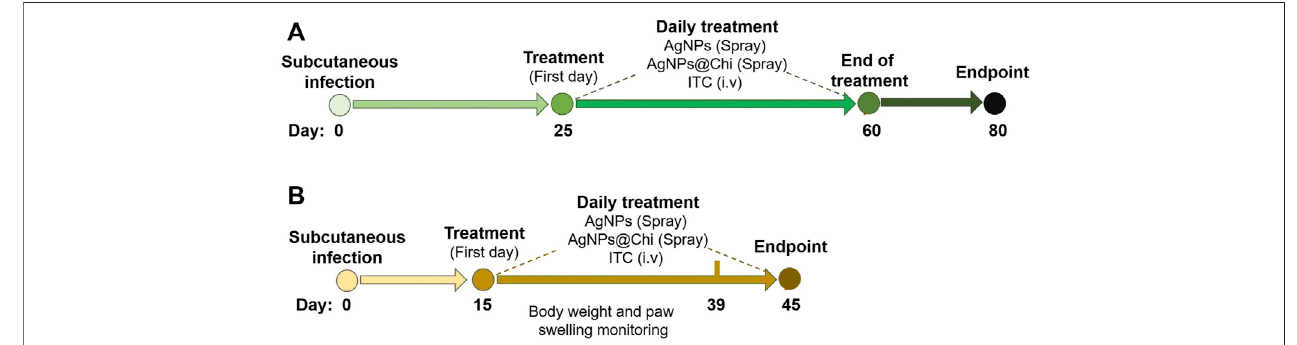
FIGURE4| Experimental schemefor invivo assays.Thestrategyused todevelop themurinesubcutaneousinfectionandantifungaltreatmentwasrepresented as a timeline. Yeasts of S. brasiliensis (5 × 10 6 cells) were inoculated by subcutaneously injection of in the left hind paw. Daily Treatment was started once the lesions were evident in all mice. In the fi rst test (A) , treatments for 35 days were performed. Then, the mice were monitored for 20 days. For the second experiment (B) , a higher virulent strain of S. brasiliensis ATCC 5110 was used, and topical treatments with NCs were administered for 30 days.